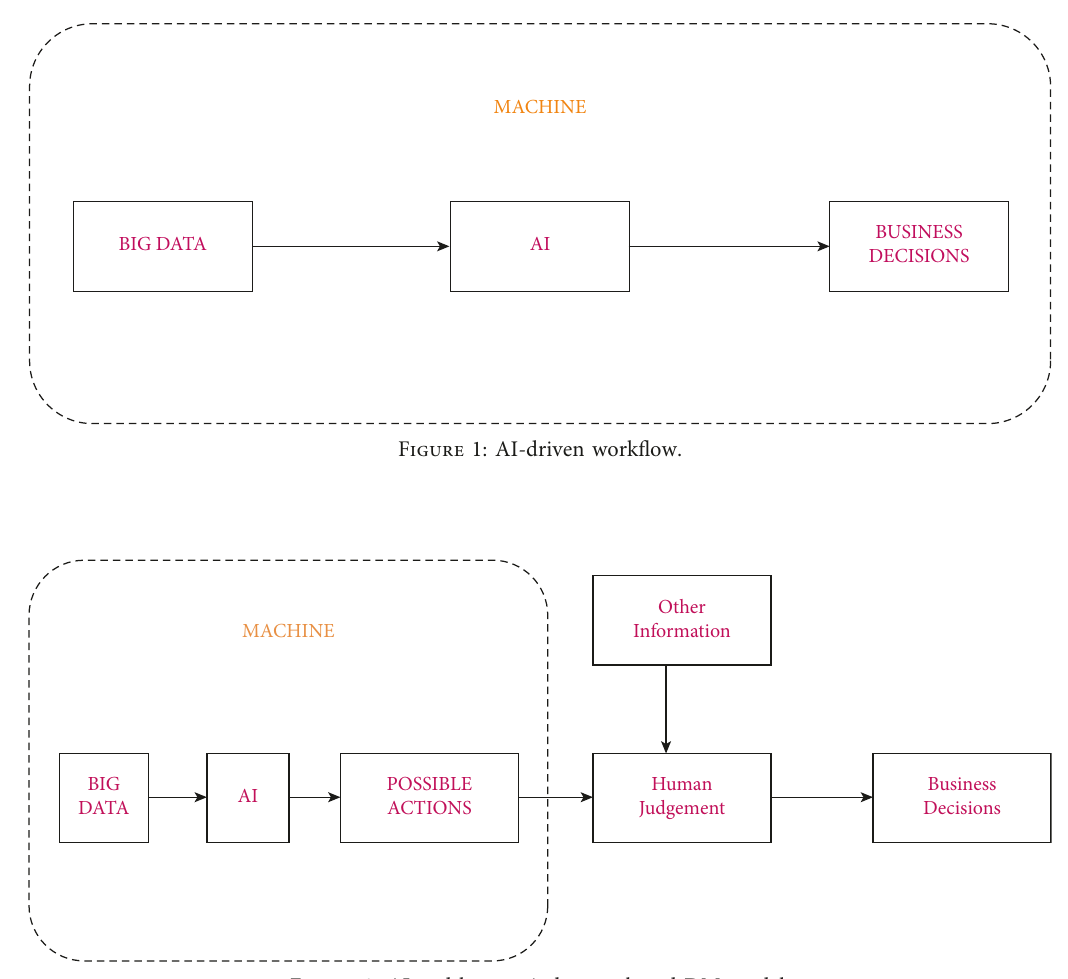
Figure 2: AI and human judgment-based DM